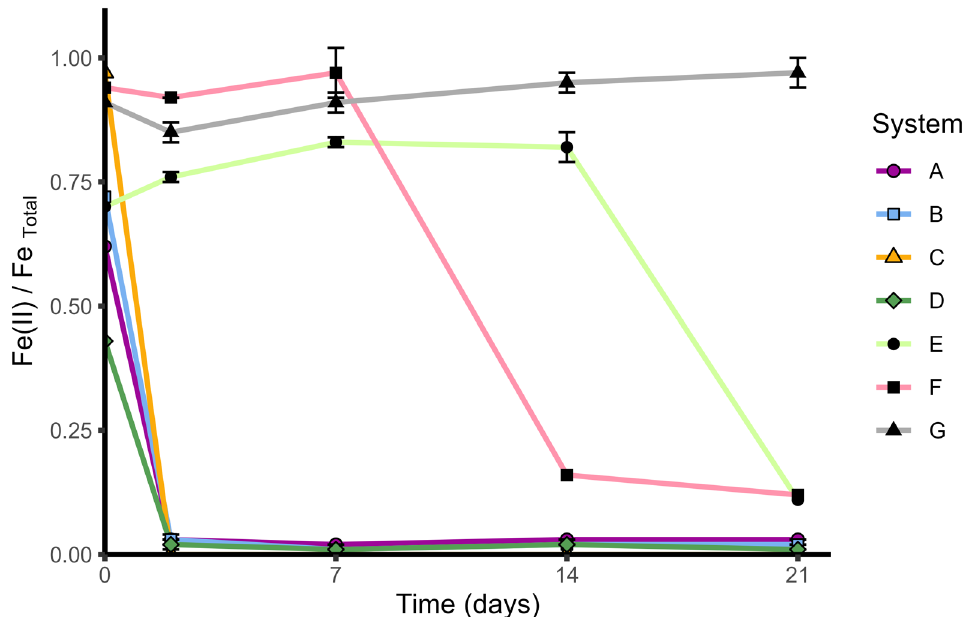
Figure 3. Evolution of Fe(II)/FeTotal ratio during bioleaching assay at 30 °C. Inoculated systems were performed in distilled water (A), MAC medium (B), and local groundwater from Taca Taca (D) with initial pH adjusted to 2.0. System (C) was performed in MAC medium with exogenous supplementation of ferrous iron and sulfur. Non-inoculated controls were performed in MAC medium (E) and with sulfur and ferrous iron supplementation (F). Sterile control (G) was performed in MAC medium using a sterilized mineral and